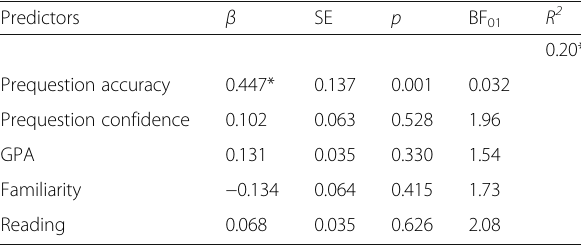
Table 1 Results of multiple regression analysis predicting postquestion accuracy